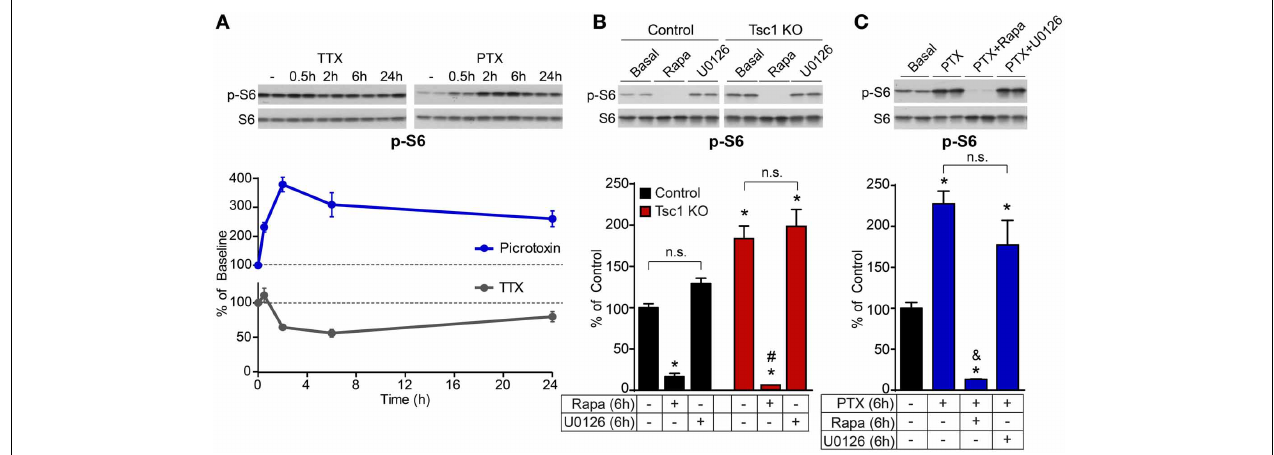
FIGURE 5 | ERK1/2 blockade does not impact basal or activity-regulated phosphorylation of the mTOR pathway target S6. (A) Western blot data of average phosphorylated S6 (p-S6, Ser240/244) levels normalized to total S6 in control neurons treated with picrotoxin (PTX, blue) or TTX (gray) for the indicated times. Dotted lines at 100% indicate baseline levels. (B) Western blot data of phosphorylated S6 in control (black) and Tsc1 KO neurons (red) following six hour treatment with 50nM rapamycin (Rapa) or 5 μ M U0126.